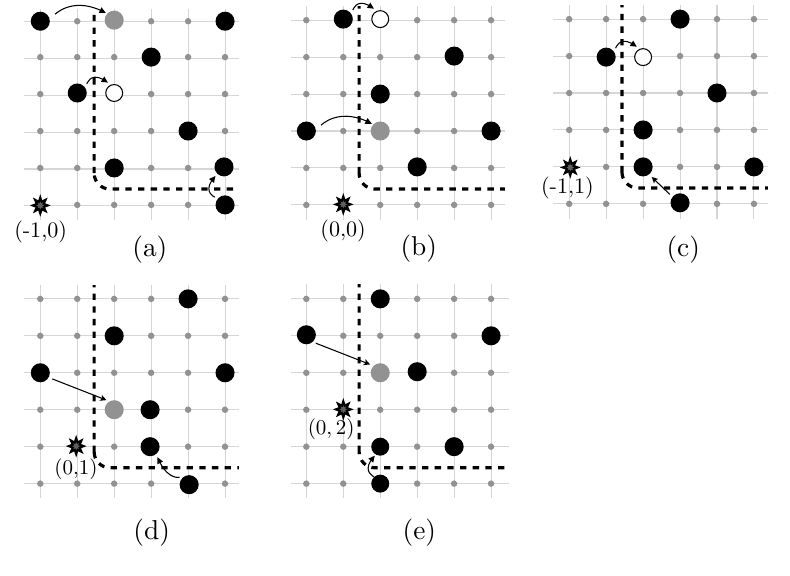
Figure 12: Lower left corner, with the core drawn on the